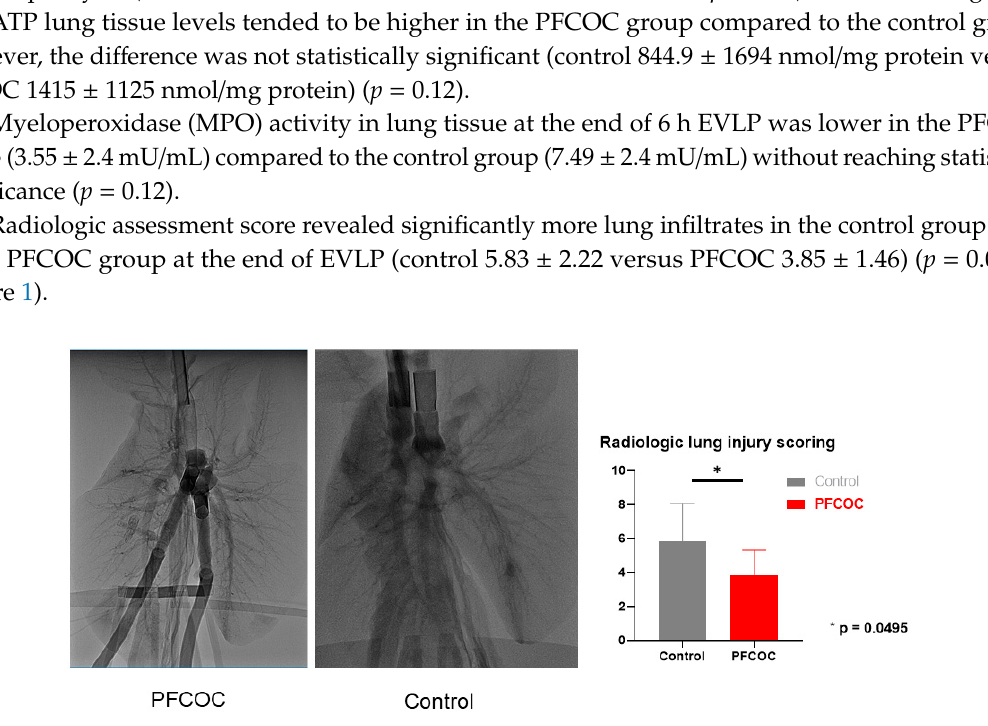
Figure 1. Radiologic assessment score. Control group showed more infiltrates than PFCOC group